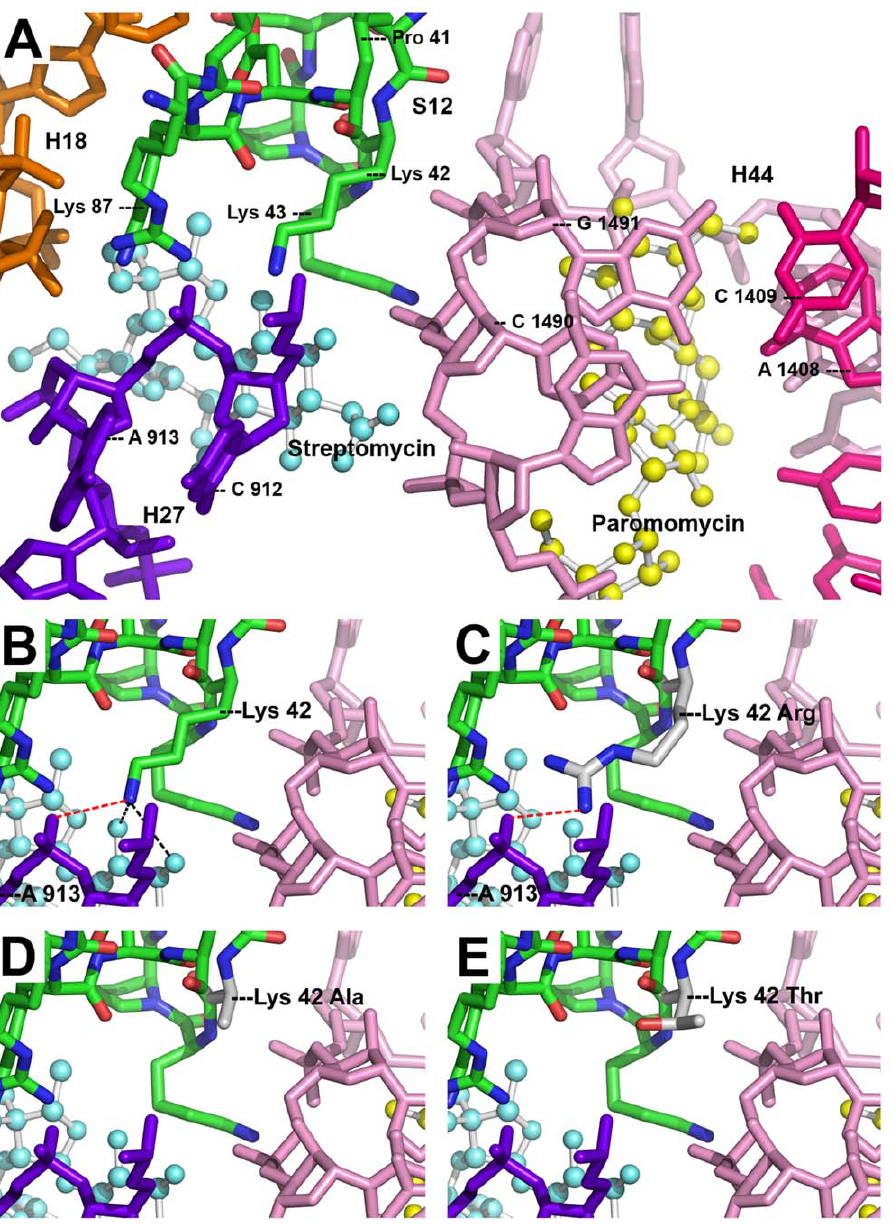
Figure 3. Three-dimensional crystal structure of T. thermophilus ribosomal decoding A-site with bound paromomycin and streptomycin. ( A ) General view of the A-site. Amino-acid residues of S12 (green) are shown labelled according to atoms: carbon – green, nitrogen – blue, oxygen – red. 16S rRNA helices are indicated as follows: H44 strand I (pink), H44 strand II (magenta), H27 (violet), H18 (orange). Streptomycin (light blue) and paromomycin (yellow). ( B ) Close up of wild type K42. Hydrogen bonds to streptomycin (black dotted lines) and salt bridge to A913 (red dotted line) are shown. ( C ) Close up of mutant K42R. Salt bridge (red dotted line) is shown. ( D ) Close up of mutant K42A. ( E ) Close up of mutant K42T. (Protein Data Bank, 1FJG.pdb).